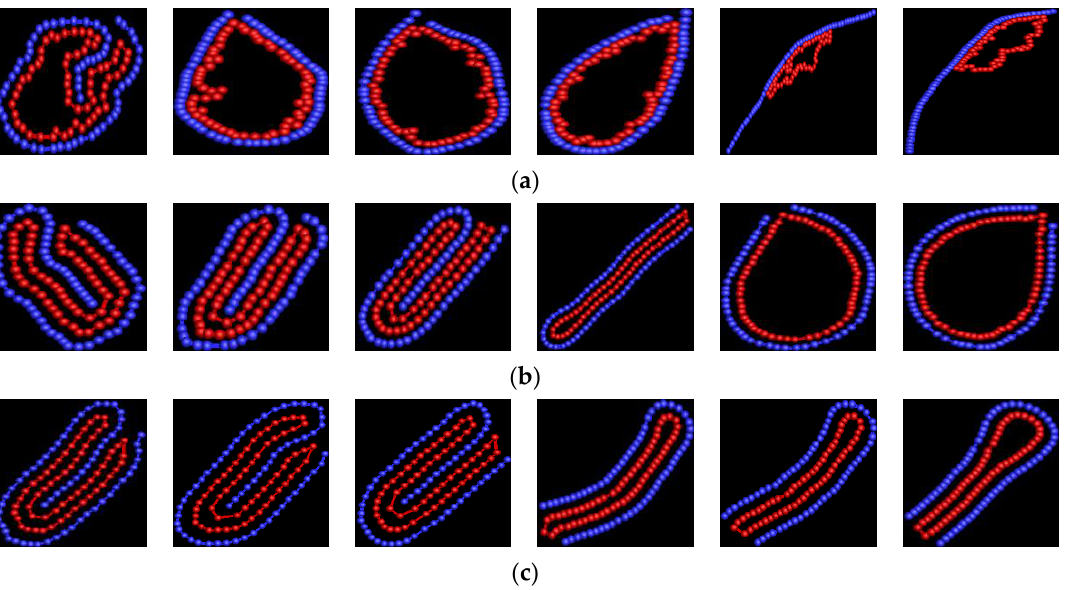
Figure 1. The snapshots of semiflexible polymer/vesicle composites. The blue one represents the linear polymer, and the red one represents vesicle. In the snapshots, the bending stiffness of polymer is 10, 50 100, 150, 200, and 300 from left to right for ( a ) ε VP = 2, ( b ) ε VP = 8, and ( c ) ε VP = 12. The average attractive polymer-vesicle energy < U VL > is discussed. < U VL > increases from − 53.83 to − 47.19 with κ increase from 10 to 50, firstly, then almost keeps constant in the range of κ = 50~150, then increases with κ increase from 150 to 200, finally keeps constant with κ increase for ε VP = 2, as shown in Figure 2. It indicates that the vesicle undergoes two phase transition with κ increase. It is in agreement with the results of Figure 1. For ε VP = 8, < U VL > has a little fluctuation in the range of κ = 10~100, then increases with κ increase from 100 to 200, finally keeps constant in the range of κ = 200~300. It indicates that there is an intermediate shape with κ increase. For ε VP = 12, < U VL > slightly increases with κ increase in the range of κ = 10~100 firstly, then increases quickly with κ in range of κ = 100~150, finally begins to increase slightly again with κ increase in the range of κ = 150~300. It indicates that the vesicle shape at κ = 10~100 is different from those at κ = 150~300. The results of mean end-to-end distance < R ee > of semiflexible polymer are in agreement with the results of Figure 2, as shown in Figure